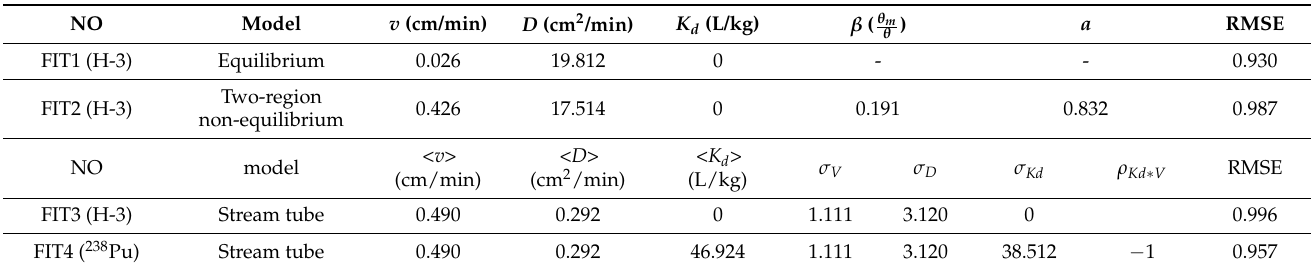
Figure 3. The experimental breakthroughs of H-3 and fitting curves. Table 5. The parameters for fitting BTCs.